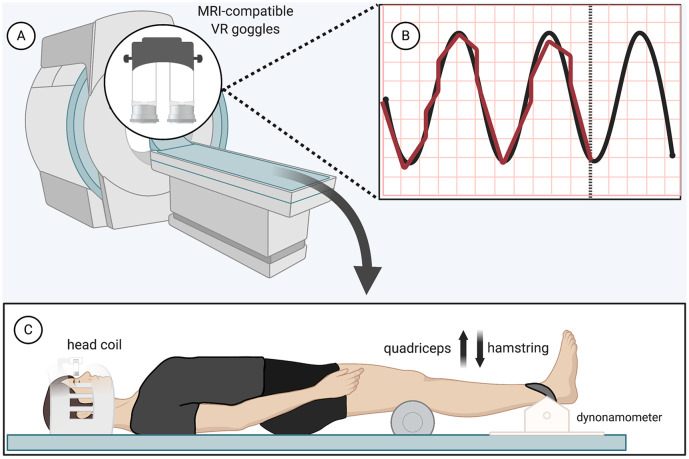
Functional magnetic resonance imaging (fMRI) force-matching task—(A) magnetic resonance imaging (MRI)-compatible virtual reality display (B) black, Sinewave graph (0–5 N, 1.2 Hz); red, real-time display of participant force (C) load cell apparatus and patient position (participant restraints not pictured). Created with Biorender.